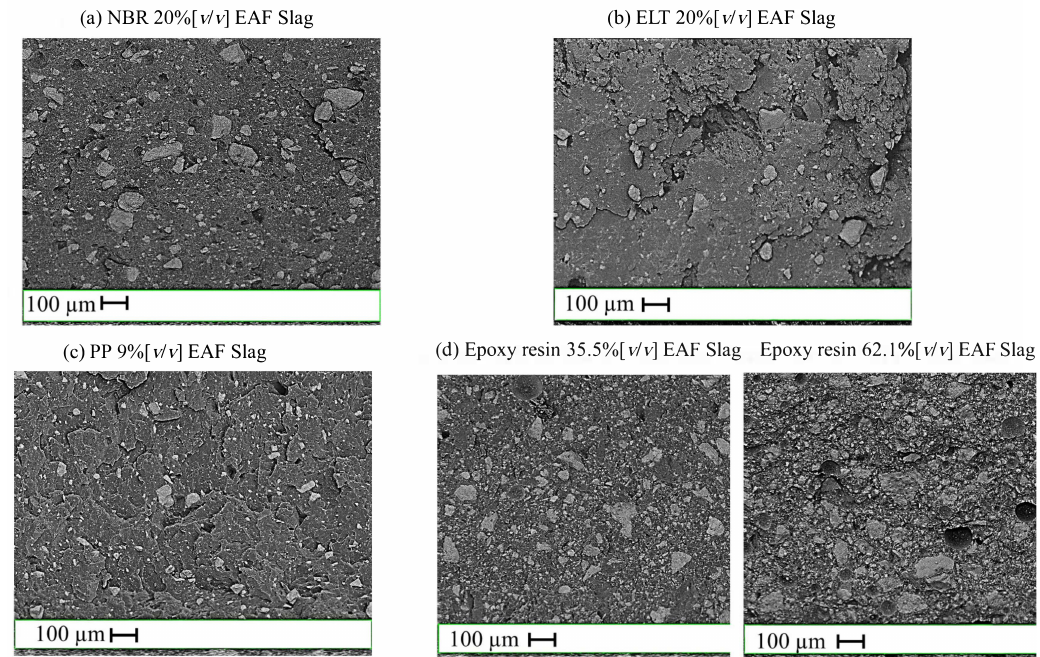
Figure 8. SEM backscattering images of cross sections of specimens broken in liquid nitrogen. ( a ) NBR filled with EAF slag 20% ( v / v ). ( b ) ELT filled with EAF slag 20% ( v / v ). ( c ) PP filled with EAF slag 9% ( v / v ). ( d ) Epoxy resin filled with EAF slag 35.5% ( v / v ). and 62.1% ( v / v ).